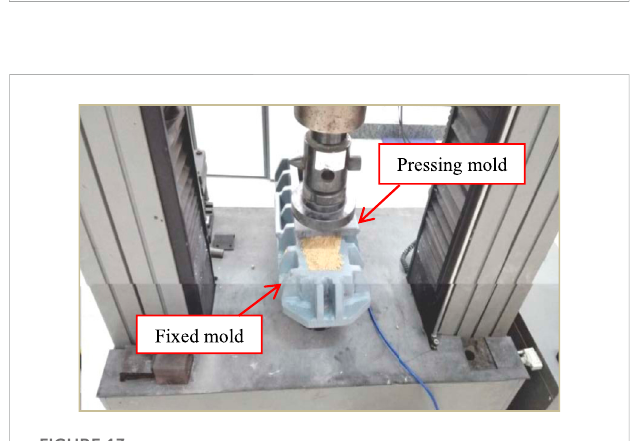
FIGURE 12 Check valve.